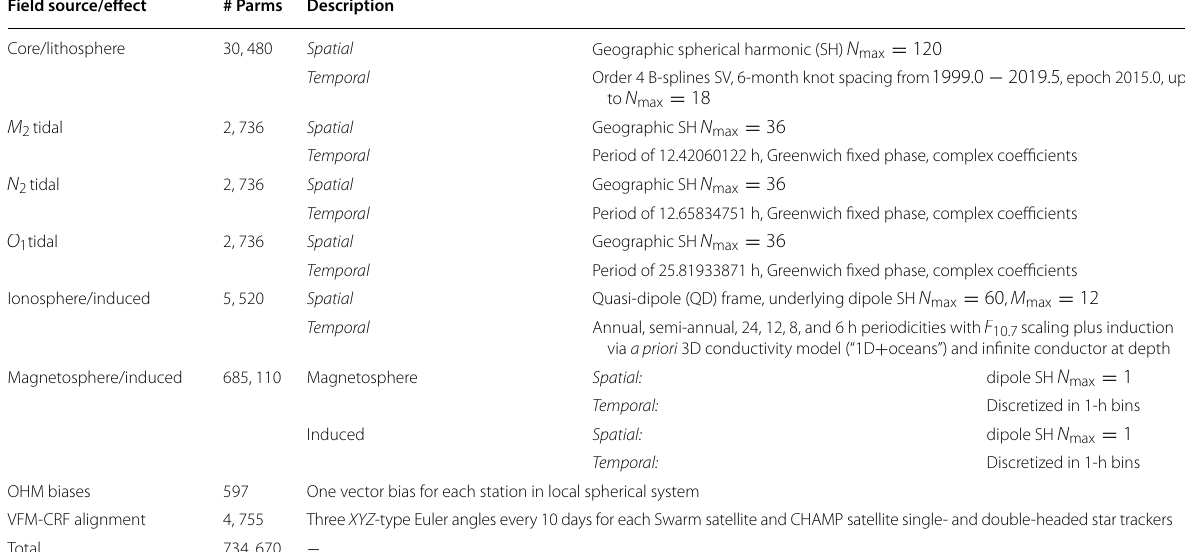
Table 1 CM6 parameterization Field